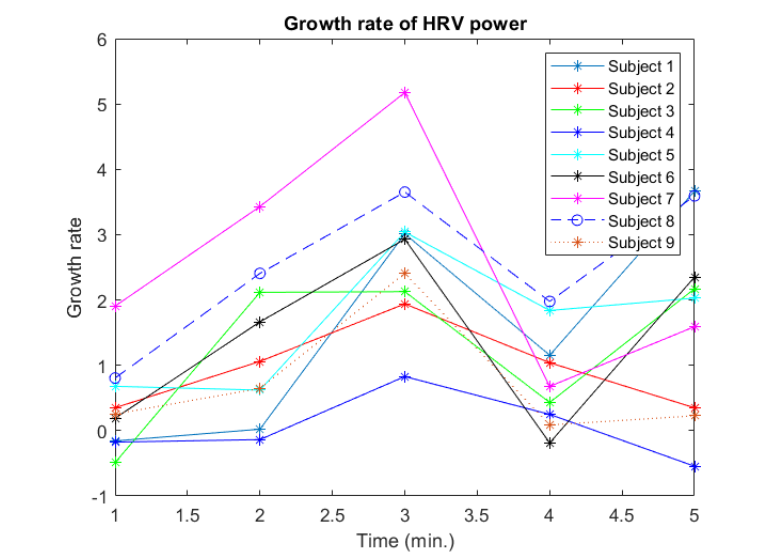
Figure 6. Experiment 1 growth rate of HRV power.